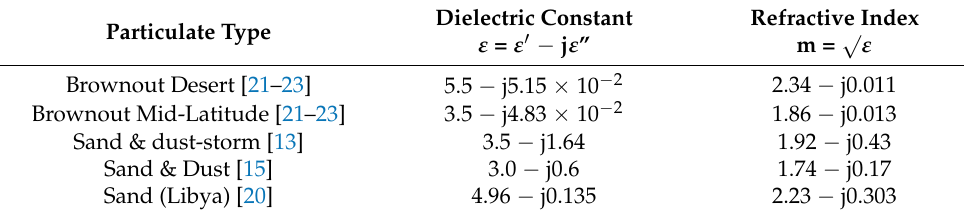
Table 1. The dielectric constants for brownout particulates.